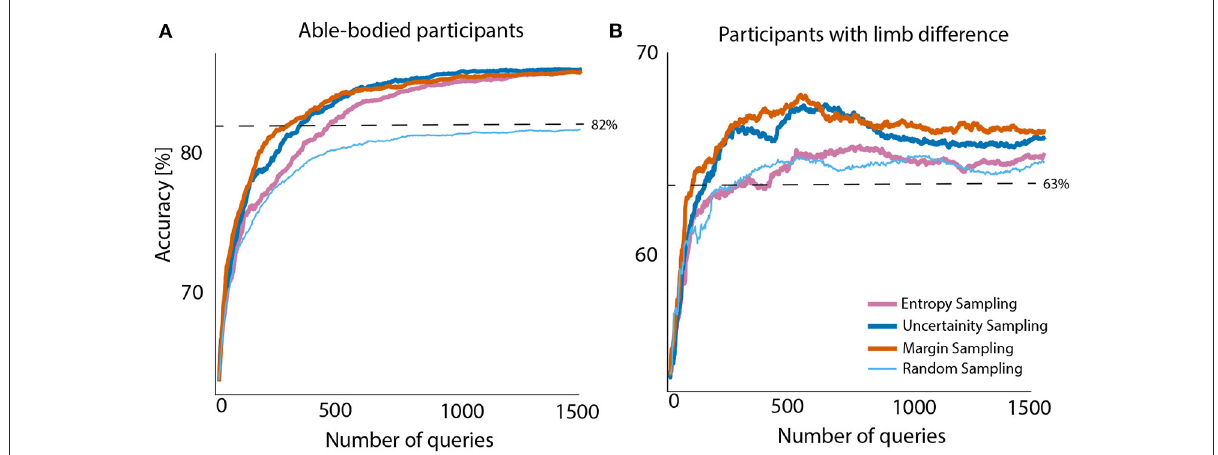
FIGURE2 Averaged test accuracy across all able-bodied participants (A) and people with limb difference (B) . Initial training sets for subjects in both groups contained 50 samples from each class. Initial accuracy without active learning is presented at query step zero. Offline baseline: 82% (A) and 63% (B) for able-bodied and people with limb loss, respectively.